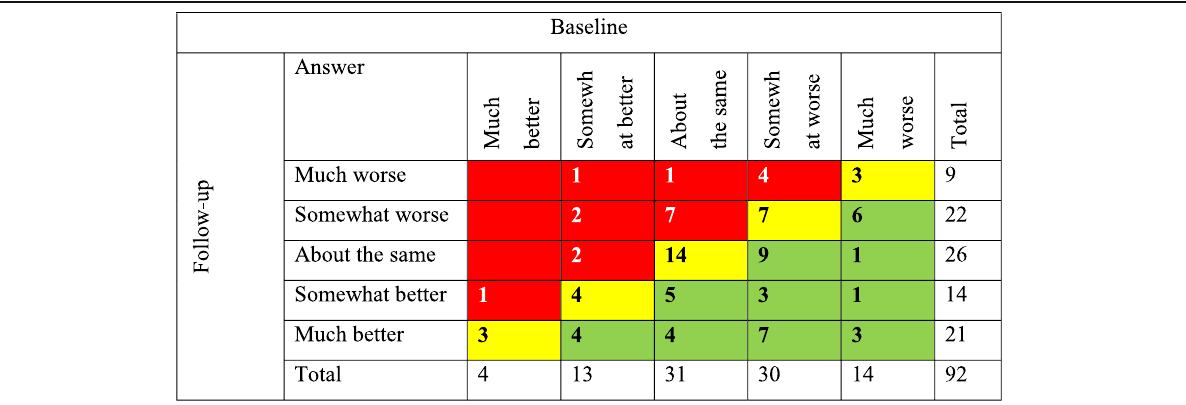
Table 5 Responsiveness: Health change item ratings for cardiac rehabilitation patients at baseline and follow-up